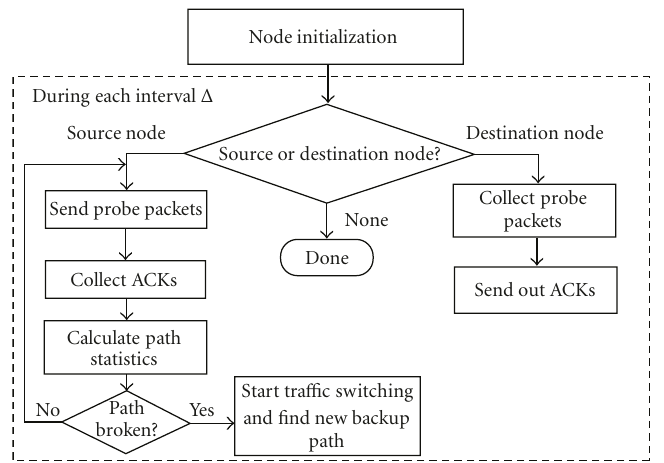
Figure 5: Software agent for tra ffi c monitoring and switching.